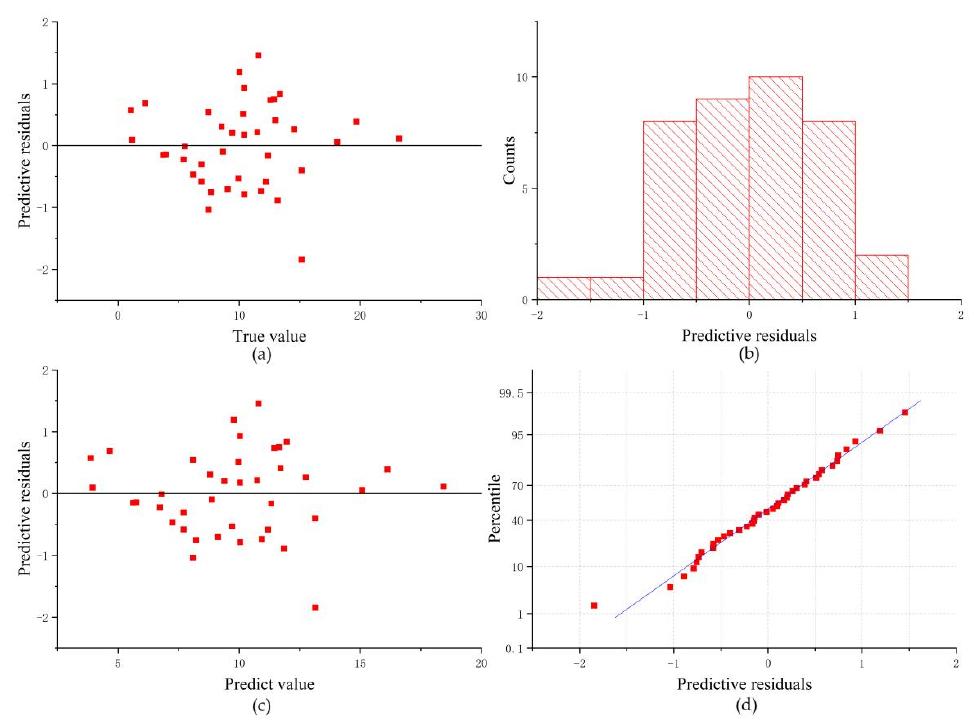
Figure 11. DEM differential interference method with random forest estimation of tree height pre- cision and fitting equation ( a ). Coherent amplitude method with random forest estimation of tree height precision and fitting equation ( b ).